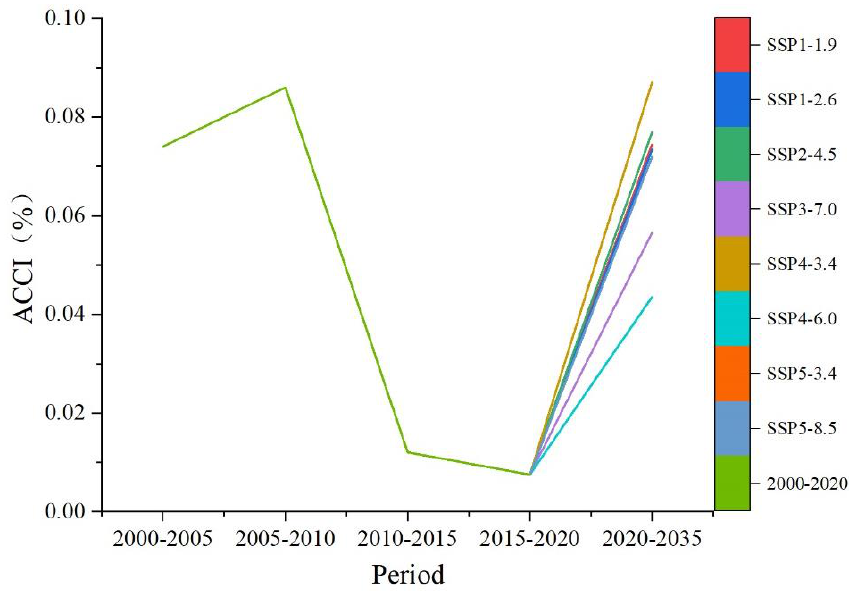
Figure 8. Changes in ACCI during 2000 – 2020 and 2020 –